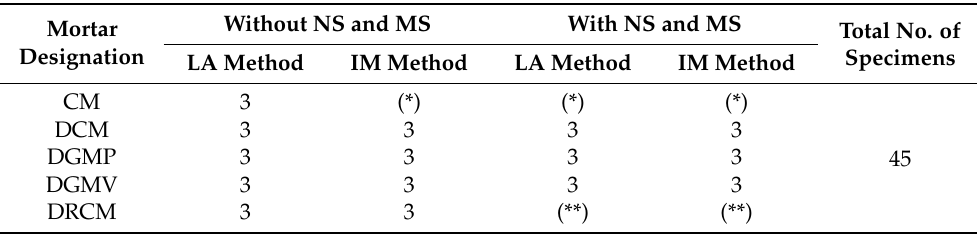
Table 3. Experimental program on steel plate